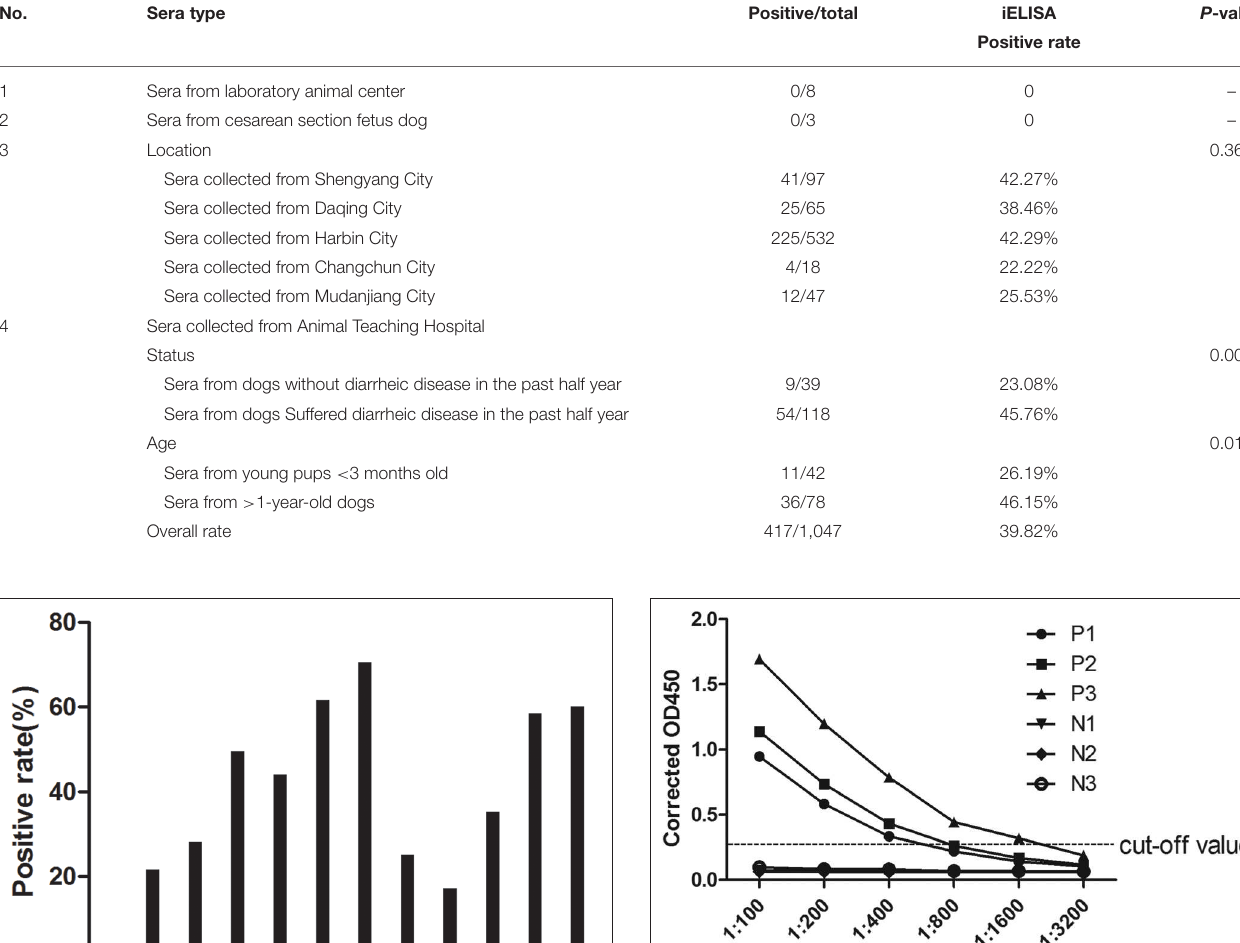
TABLE 5 | Summary of the CanineCV results of the sera tested by iELISA. No.